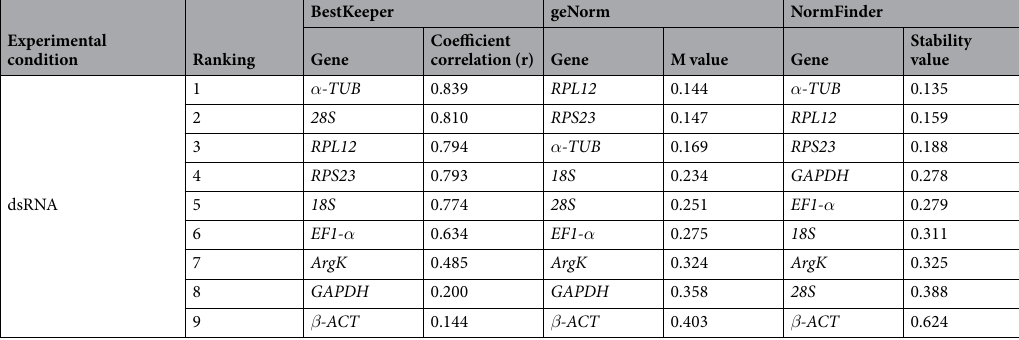
Table 2. Stability of candidate reference genes according to BestKeeper, geNorm and